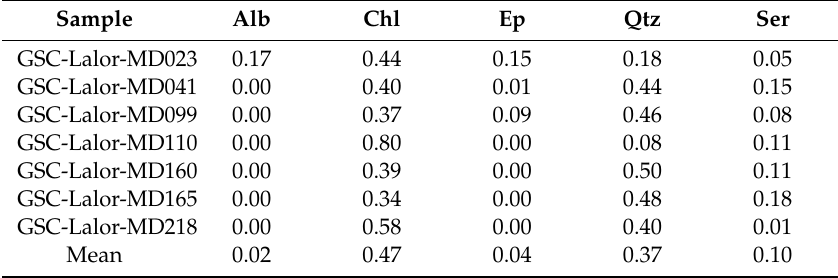
Table 7. Greenschist facies normative minerals for modeling the hydrothermal conduit.